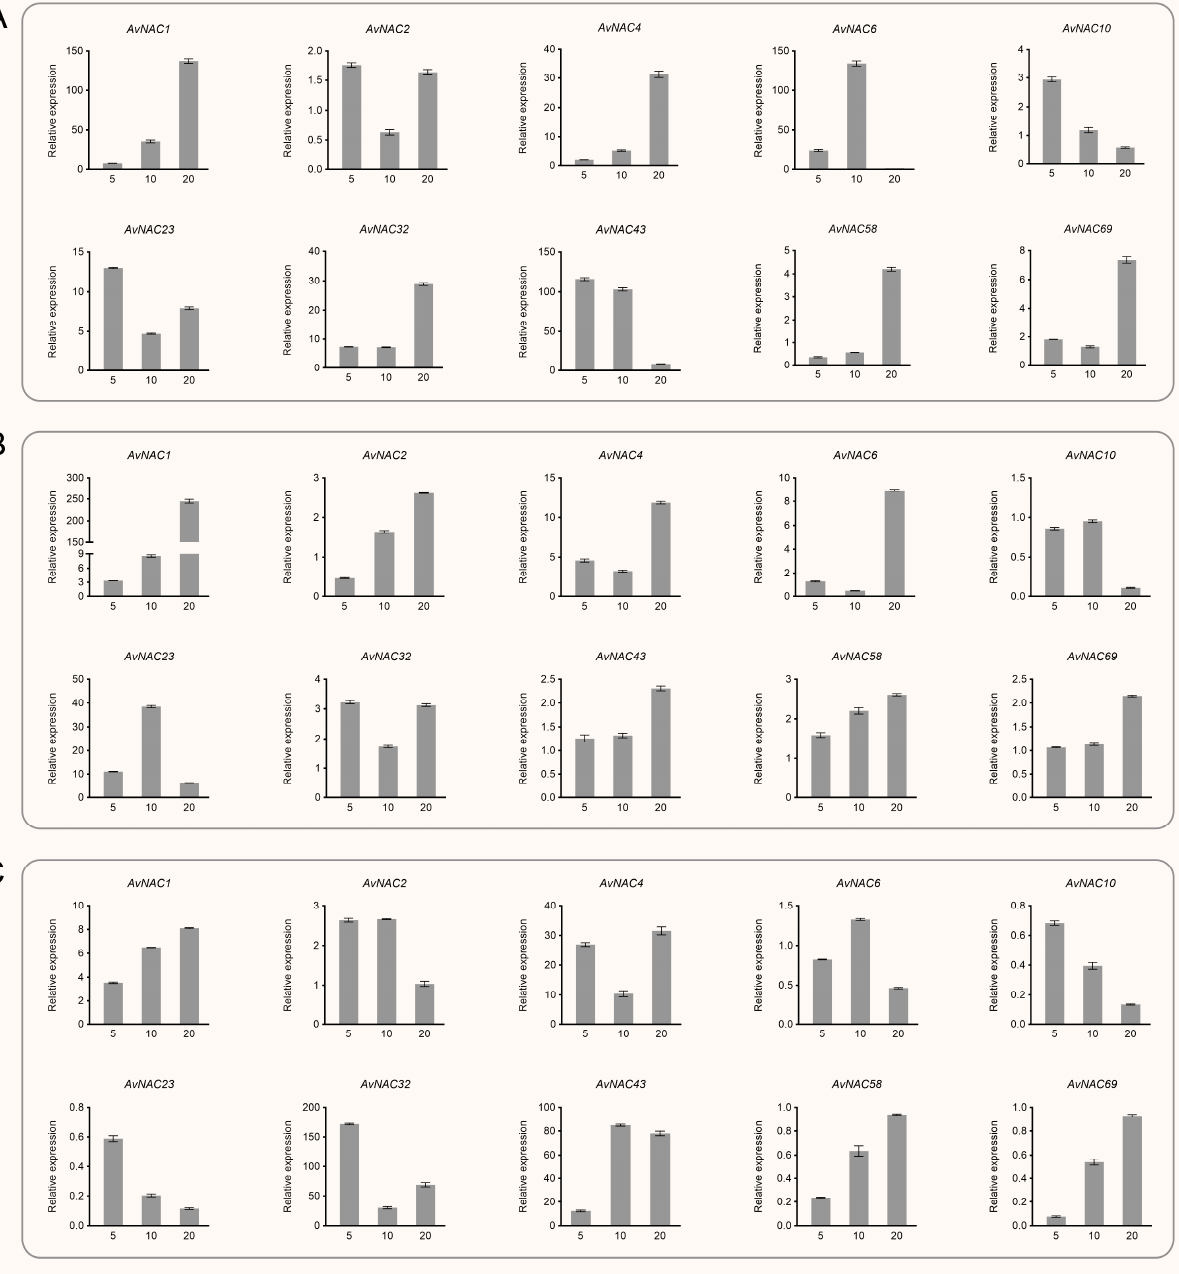
Figure 8. Relative expression of selected AvNAC genes in various tissues of A. venetum under drought stress (0, 5, 10, 20% PEG6000 treatment). ( A ) Leaf. ( B ) Stem. ( C ) Root.